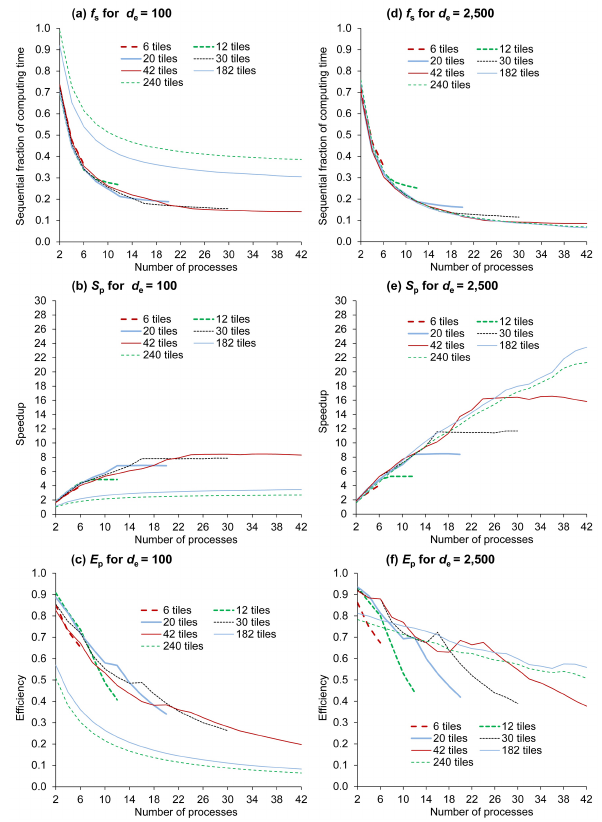
Figure 5. The serial fraction of code f s , speedup S p and efficiency E p , plotted against the number of processes p for different values of the number of tiles t and average number of ellipsoids per pixel, d e . See text for further